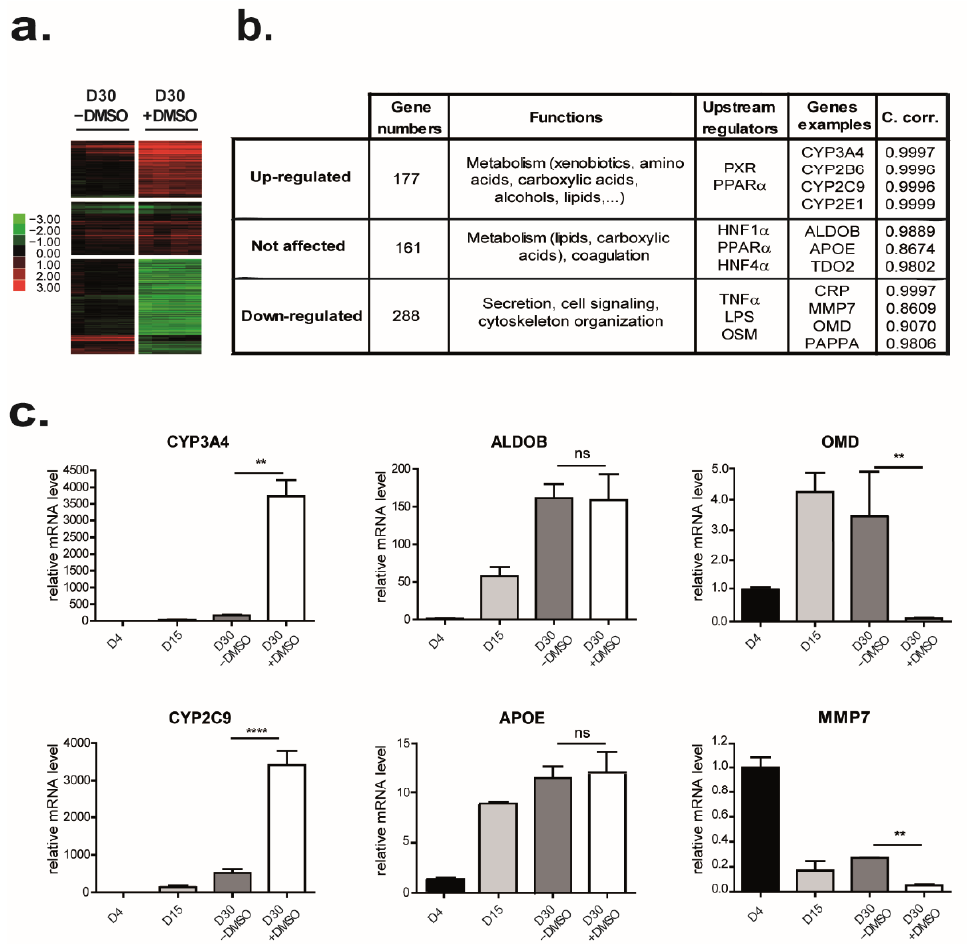
Figure 2. Effects of DMSO on HepaRG cell differentiation. Genes were grouped based on the effects of DMSO addition during the latter part of the HepaRG cell differentiation procedure. ( a ) Heat map of the 3 groups of genes: upregulated, not affected, and downregulated by DMSO exposure. Green indicates lower expression and red indicates higher expression. ( b ) Top functional categories and upstream transcriptional regulators associated with each gene group highlighted by IPA were summarized in the table. The coefficient of correlation (between microarray and real-time RT-PCR data) was calculated for each mentioned gene. ( c ) Genes whose expressions were upregulated (left panel), not affected (middle panel), and downregulated (right panel) were selected based on the microarray data. The expression of each selected gene was confirmed by real-time RT-PCR (n = 3). Results are expressed as relative to condition D4, arbitrary set to 1. ** p < 0.01; **** p < 0.001; ns: not significant.